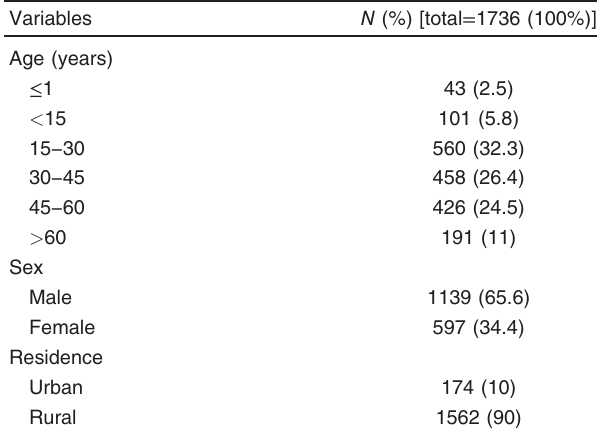
Extra-Pulmonary TB